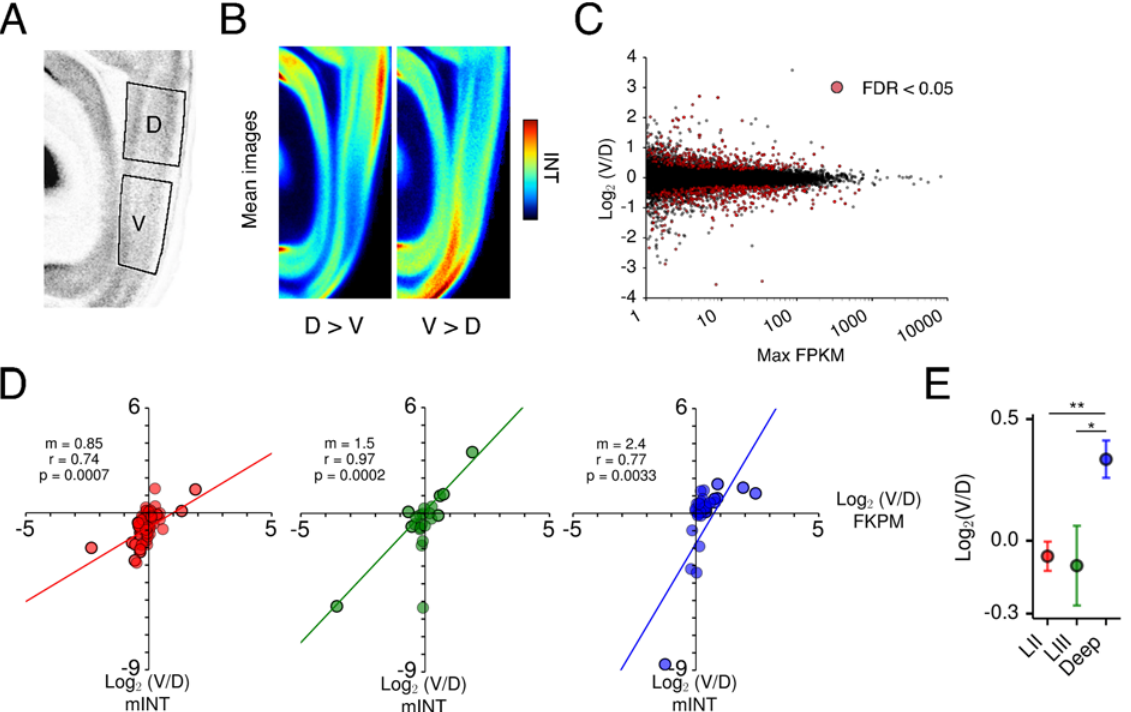
Figure 7. Dorsoventral organization of gene expression in MEC. (A) Boxes overlaid on MEC region of the central reference image indicate the regions from which pixel intensity was measured and a mean calculated. Pixel intensity was also measured from the adjacent lateral image if present in the re- registered ABA data set. Intensities for dorsal and ventral regions were averaged across the 2 planes to give a mean (mINT) in the dorsal and ventral regions. (B) Average images indicate mean expression patterns for genes with higher dorsal (D > V) and higher ventral (V > D) expression that have images in the central plane. Genes were classified based on the following criteria: All: mINT MEC (cid:1) 2, D > V: log 2 (V/D) mINT (cid:3) -0.2630, V > D: log 2 (V/D) mINT (cid:1) 0.2630. (C) Identification of dorsoventrally patterned genes using Cuffdiff 2 differential expression analysis [58] of RNA-Seq data. Scatterplot shows log 2 (Ventral FPKM/Dorsal FPKM) as a function of absolute FPKM. Significant genes (FDR < 0.05) are indicated in red. Only genes with mean FPKM (cid:1) 1 across samples and that had a sufficient number of reads for analysis were included. (D) Scatterplots show log 2 (V/D) mINT for ABA images of genes with layer-specific expression as a function of log 2 (V/D) FPKM for corresponding RNA-Seq data points. Slopes ( m ) were obtained using a linear regression analysis. Black outlines indicate genes with FDR < 0.05 using Cuffdiff 2 analysis. (E) The ratio of ventral to dorsal expression is significantly higher for deep-layer specific genes than superficial layer specific genes (1-way ANOVA F = 7.47, p = 0.0008. Post-hoc Tukey ’ s HSD LII vs. Deep p = 0.0016, LIII vs. Deep: p = 0.010).